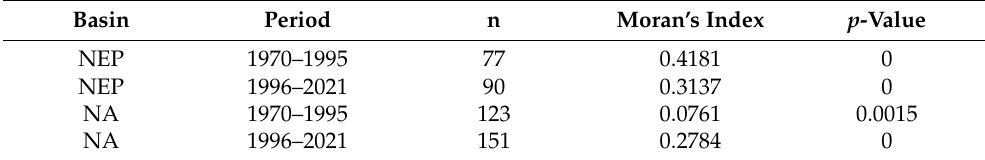
Table 1. Spatial autocorrelation and number of cells (n).